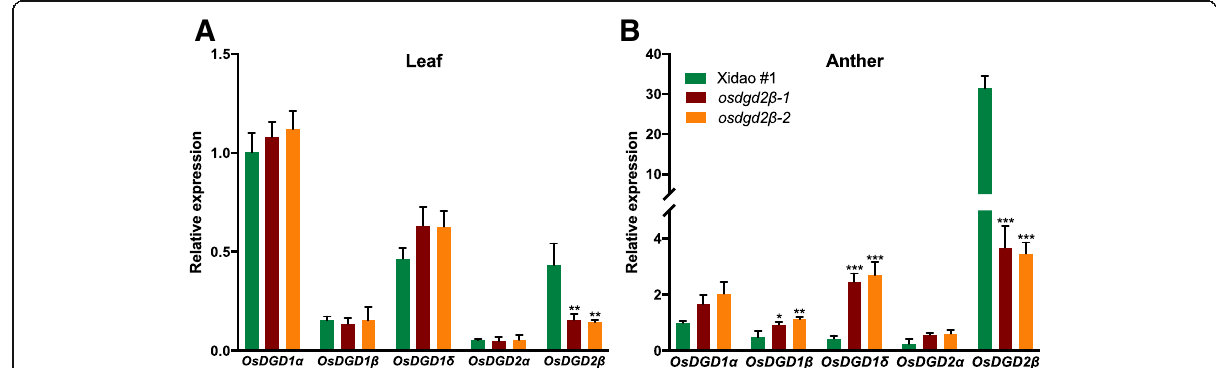
Fig. 6 Relative gene expression levels of DGDG synthesis genes in leaf ( a ) and anther ( b ) of a wild-type cultivar Xidao #1 and its mutants osdgd2 β -1 and osdgd2 β -2 . The expression levels were first normalized to the internal control gene OsACTIN and reported relative to the expression level of OsDGD2 β in wild-type (assigned a value of 1). All values represent means ± standard deviations. Asterisk represent statistically